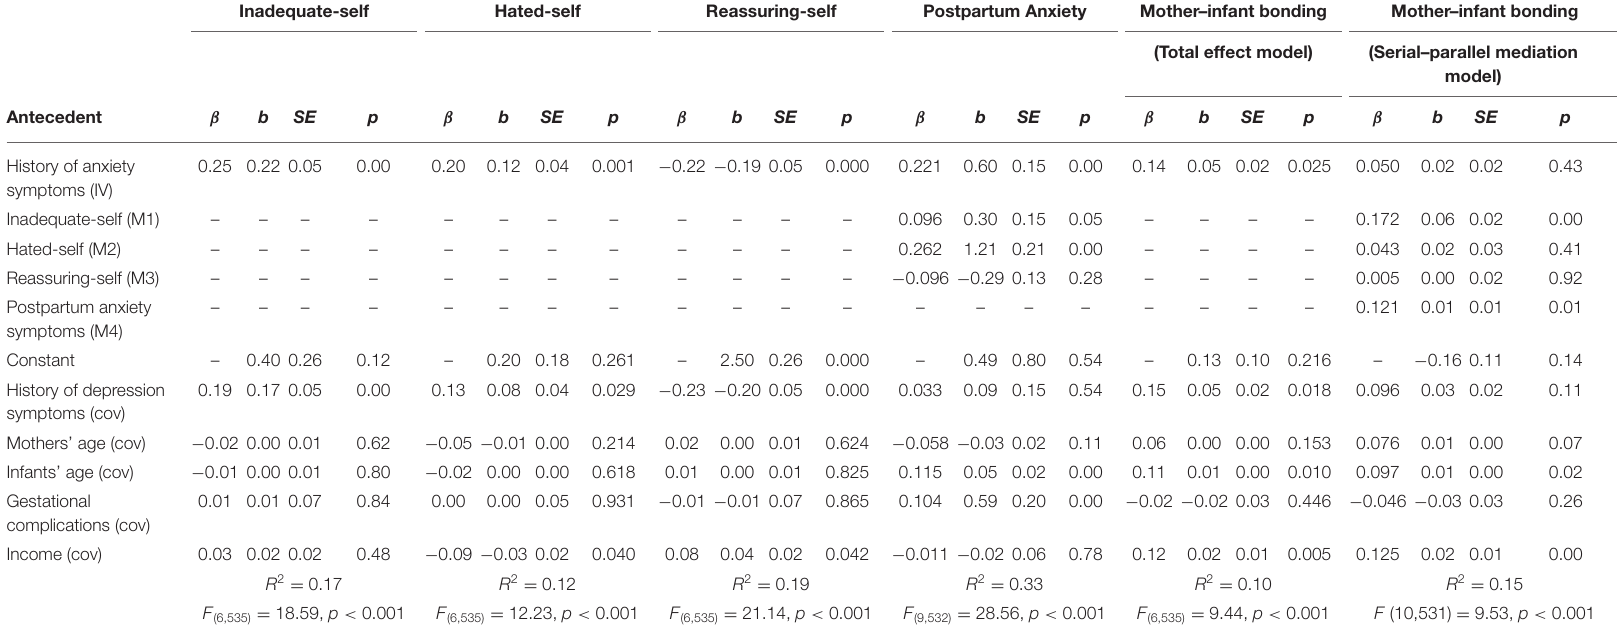
TABLE 5 | Standardized regression coefficients ( β ), unstandardized regression coefficients ( b ), standard errors (SE), and model summary information for the tested serial–parallel mediation Model